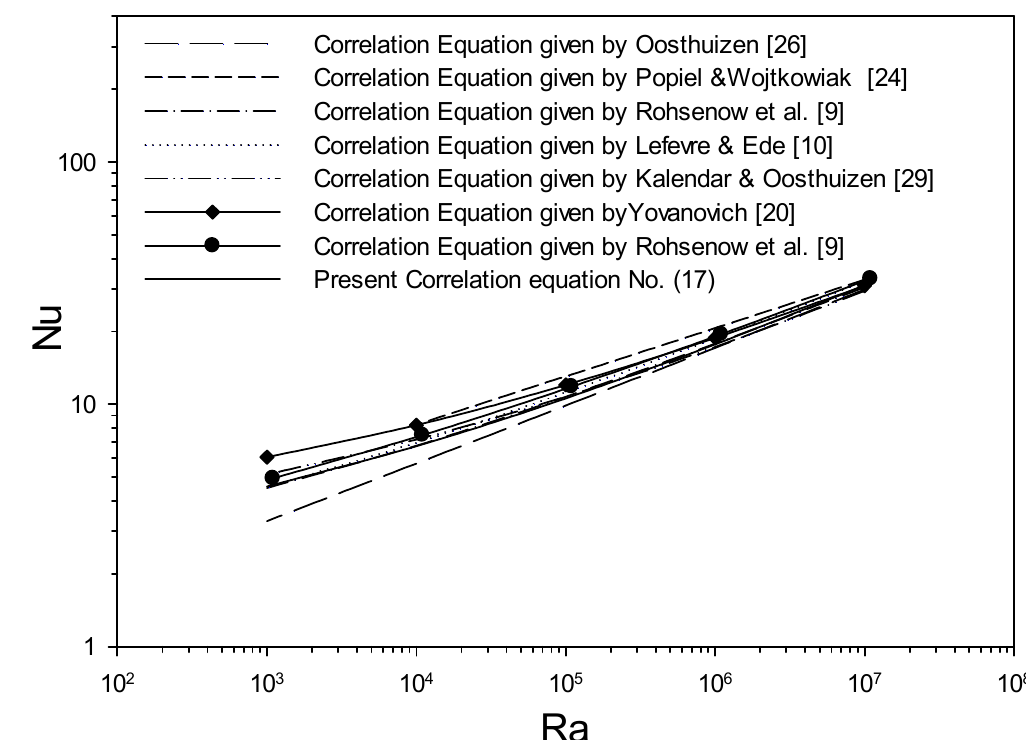
Figure 22. Comparison between present correlation Equation (17) and correlation equations available in the literature for inclination angle φ = 0 ° and W = 0.25.